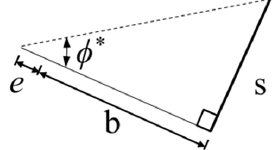
Figure A1. Fully open shaft crack at the ( a ) starting position and ( b ) instant the crack begins closing.